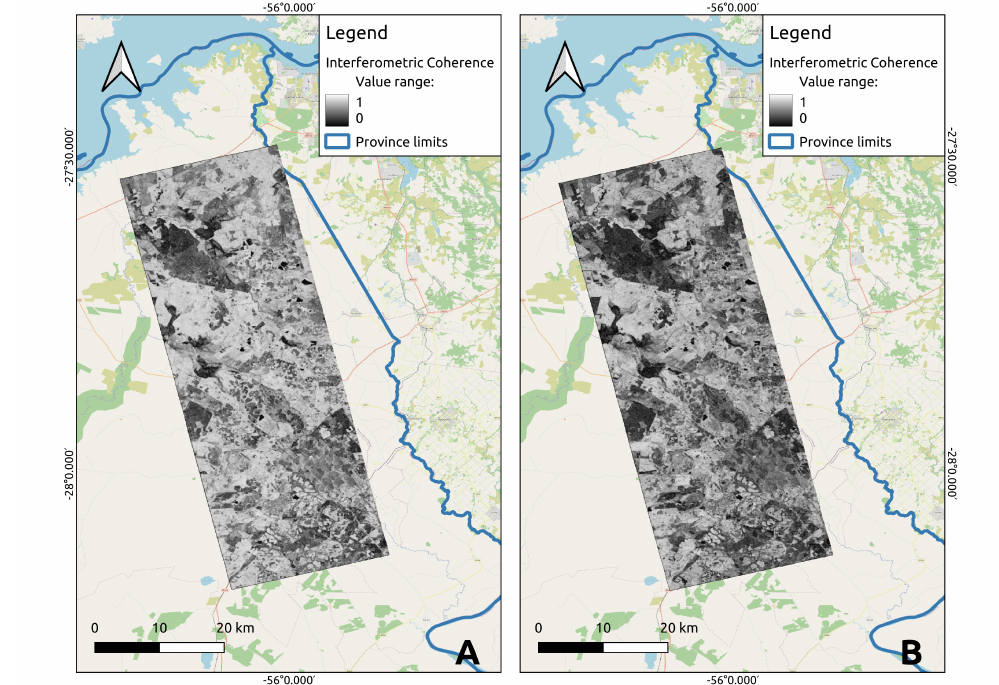
Figure 10. Visual comparison of | γ VV | of SAOCOM-1: ( A ) 8-day pair, 3 in Table 2, and ( B ) 16-day pair, 4 in Table 2.